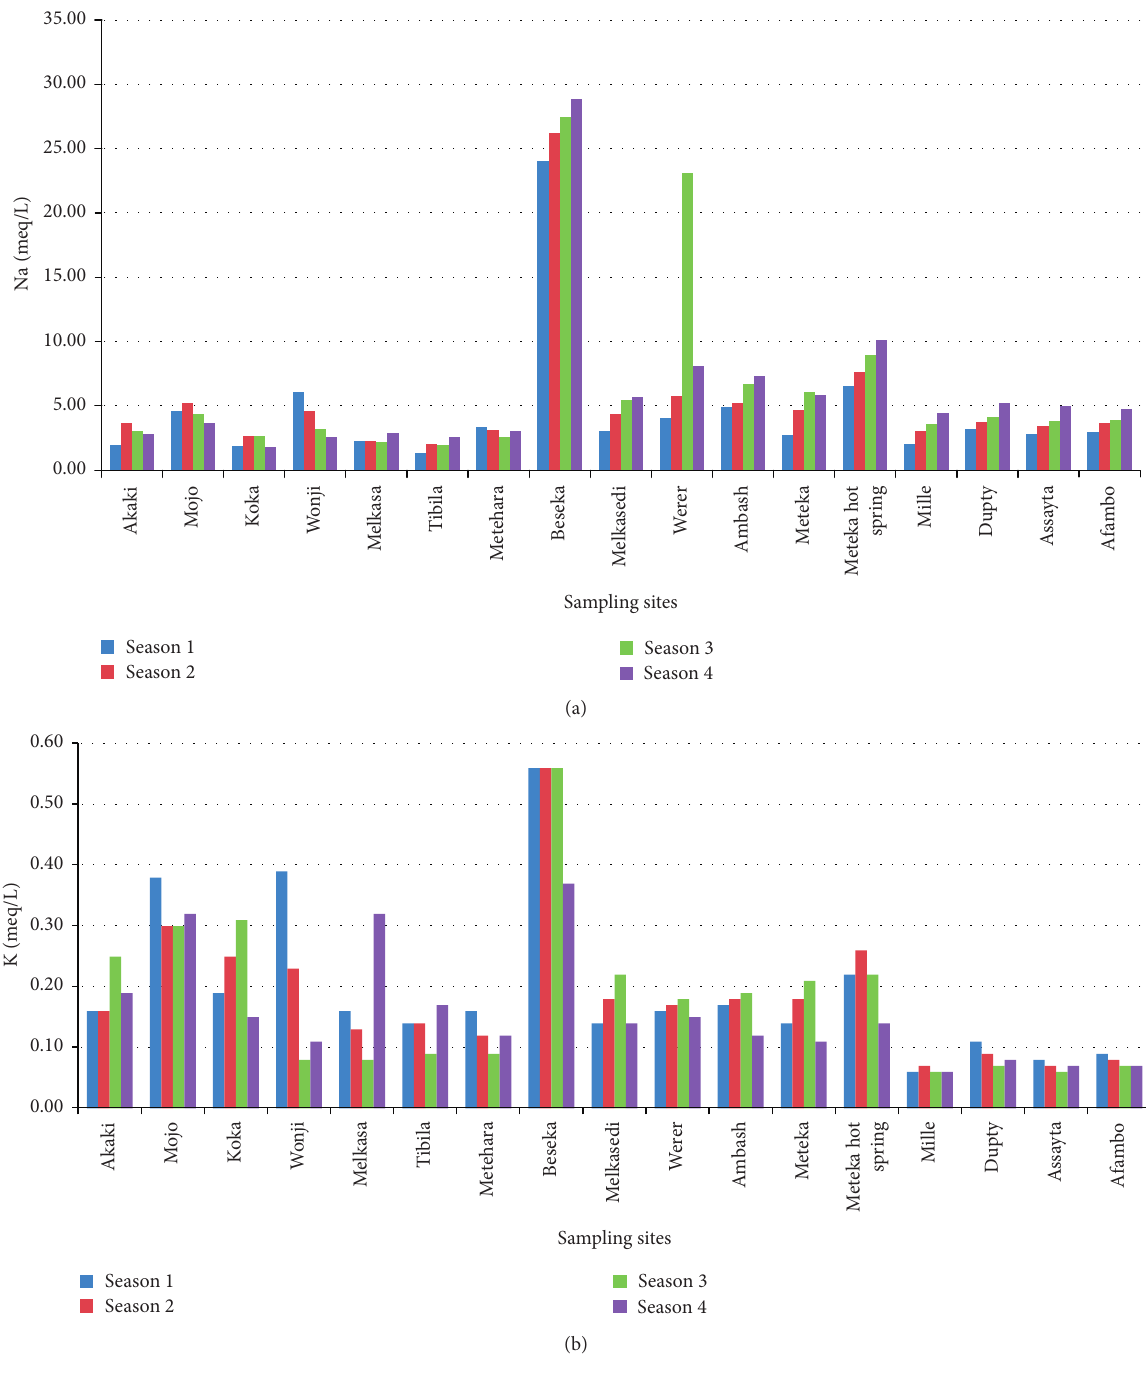
Figure 3: Mean seasonal variation of Na across different locations over years